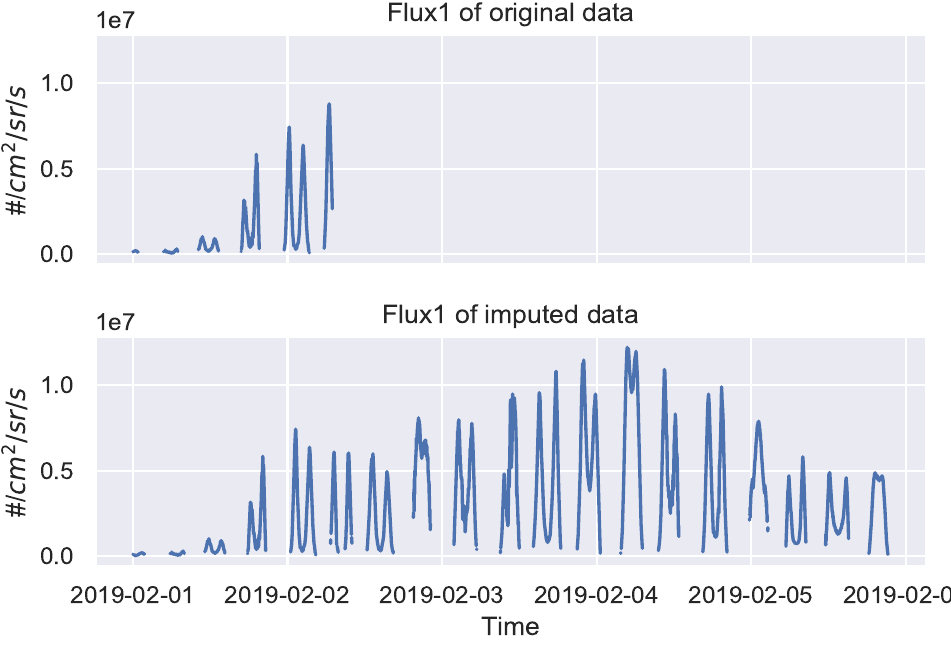
Figure 10. Top panel: original Beidou MEO data (contain lots of missing data); Bottom panel: Imputed data (the missing data have been imputed). Showing Flux1 from 2019-02-01 to